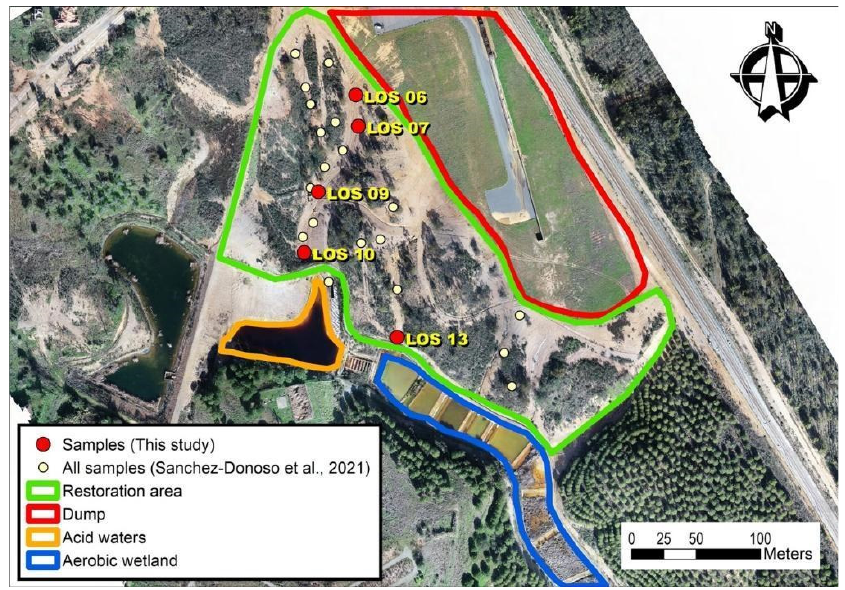
Figure 1. Location of samples in the restoration area.